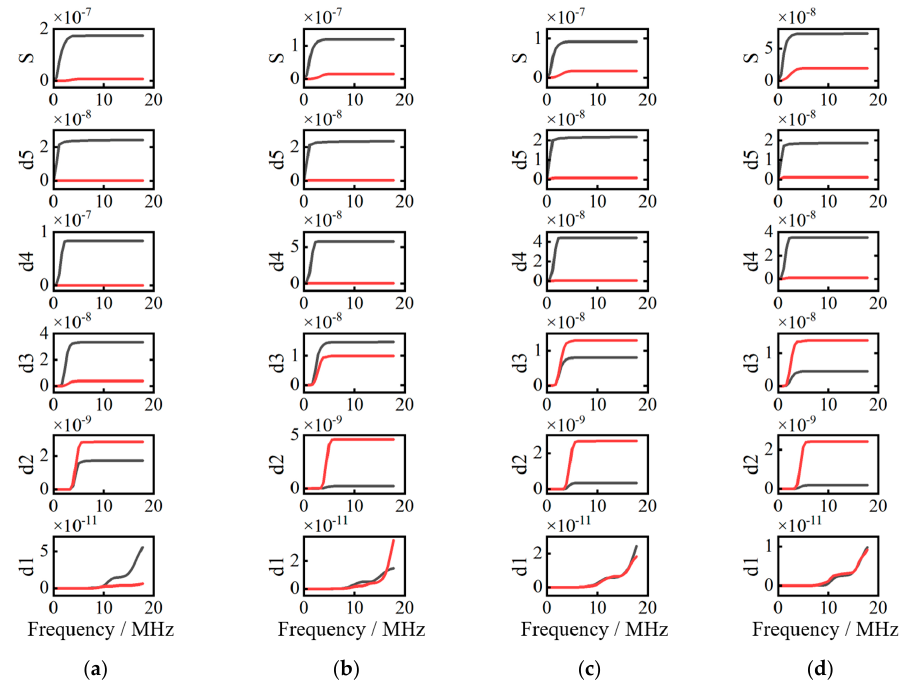
Figure 8. The energy distribution vs. frequency spectrum. ( a ) Crack depth is 0.2 mm, ( b ) crack depth is 0.3 mm, ( c ) crack depth is 0.4 mm, and ( d ) crack depth is 0.5 mm.